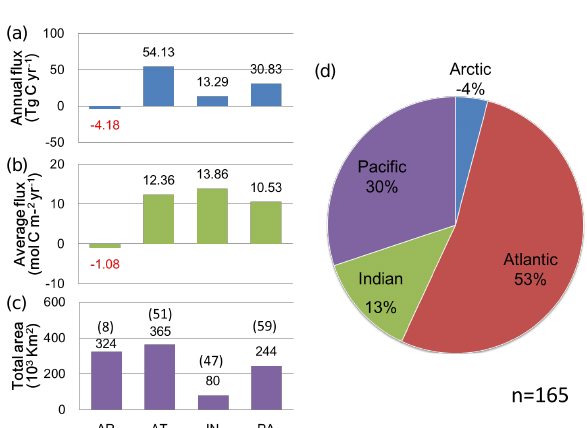
1 Fig. 7. Annual CO 2 flux (a) , average CO 2 flux per unit area (b) , Figure 7. Annual CO 2 flux (a), average CO 2 flux per unit area (b), total surface area (c), and percentage of 2 total surface area (c) , and percentage of total CO 2 flux (d) from es- total CO 2 flux (d) from estuaries of each ocean. Numbers in parentheses indicate the number of 3 estuaries studied. 4 tuaries of each ocean. Numbers in parentheses indicate the number 5 of estuaries